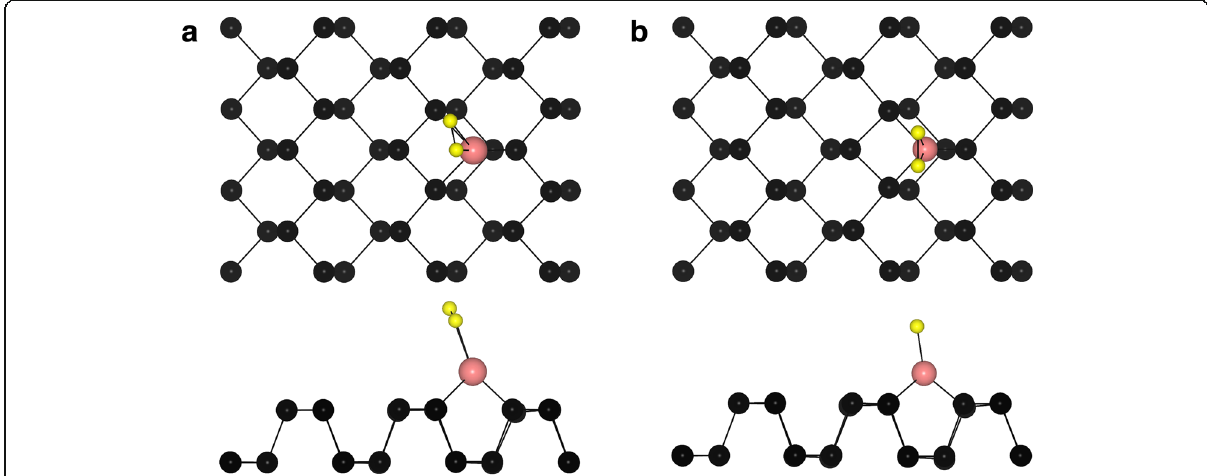
Fig. 3 Top and side views of typical adsorption sites of an O 2 molecule on TM-phosphorene. The black, pink, and yellow spheres represent P, TM, and O atoms, respectively